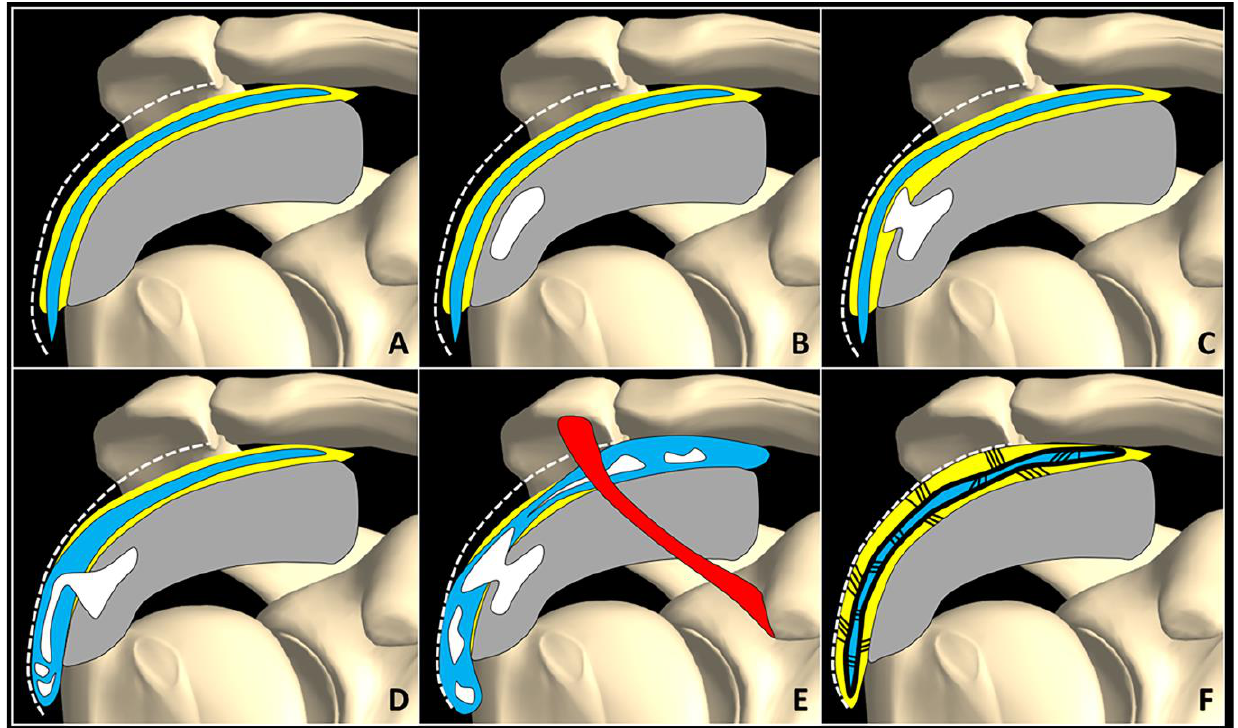
Figure 3. Normally, fat tissue ( yellow ) is located in between the SASD bursa ( blue ), rotator cuff tendons ( grey ), and the subdeltoid fascia ( white dotted line ) ( A ). Intra-tendinous calcification ( white ) ( B ) may progressively migrate within the peribursal space ( C ), and perforating the synovial lining, may slip inside the bursal cavity involving its lateral recess ( D ) or the entire chamber ( E ). A potential complication of acute microcrystalline bursitis is adhesive bursopathy ( F ) characterized by thickening of the synovial walls ( thick black line ) and intra/peri-bursal adhesions ( thin black lines ). Adhesions reduce the bursal gliding, “gluing” it to the rotator cuff tendons and subdeltoid fascia. Red: coracoacromial